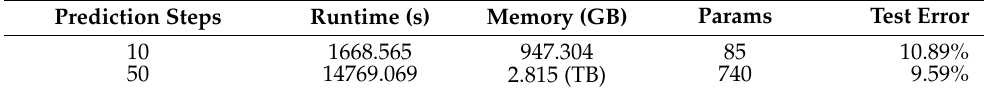
Table 4. Lorenz prediction